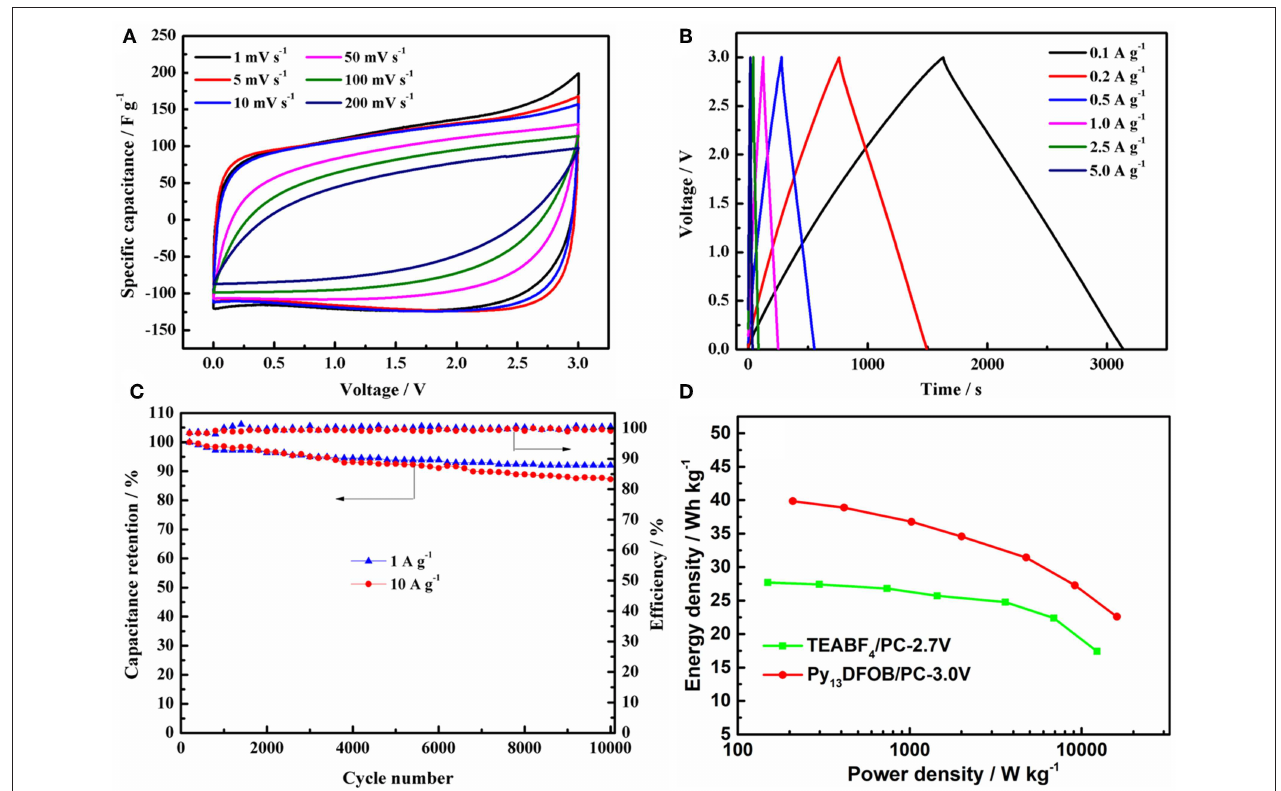
FIGURE 7 | (A) GCD curves at different current densities (B) CV curves at different scan rates (C) cycle performance at current density of 1A g − 1 and 10A g − 1 under 3.0V of the EDLCs using 1.0mol L − 1 Py 13 DFOB/PC. (D) Ragone plots of the EDLCs with two